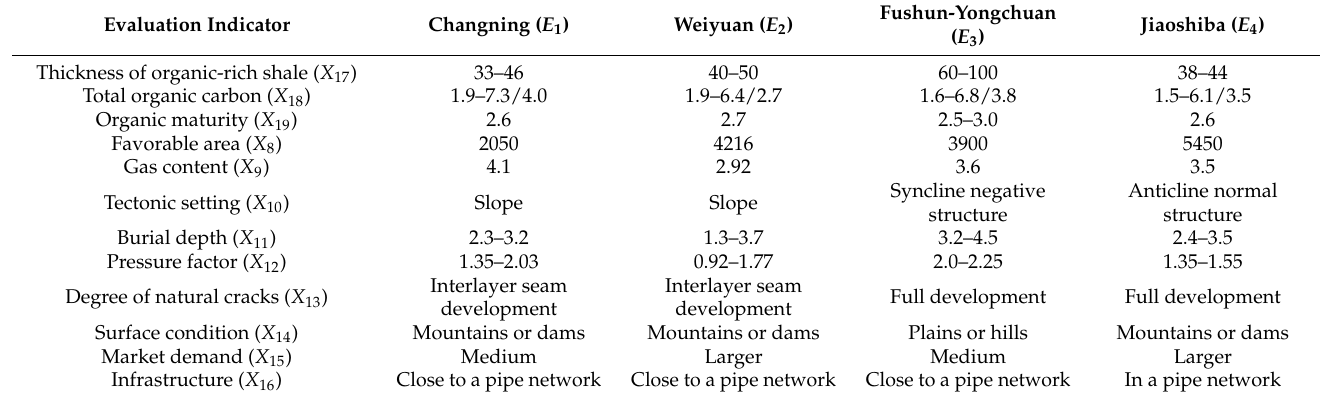
Table 5. Shale-gas data of four areas in the Sichuan